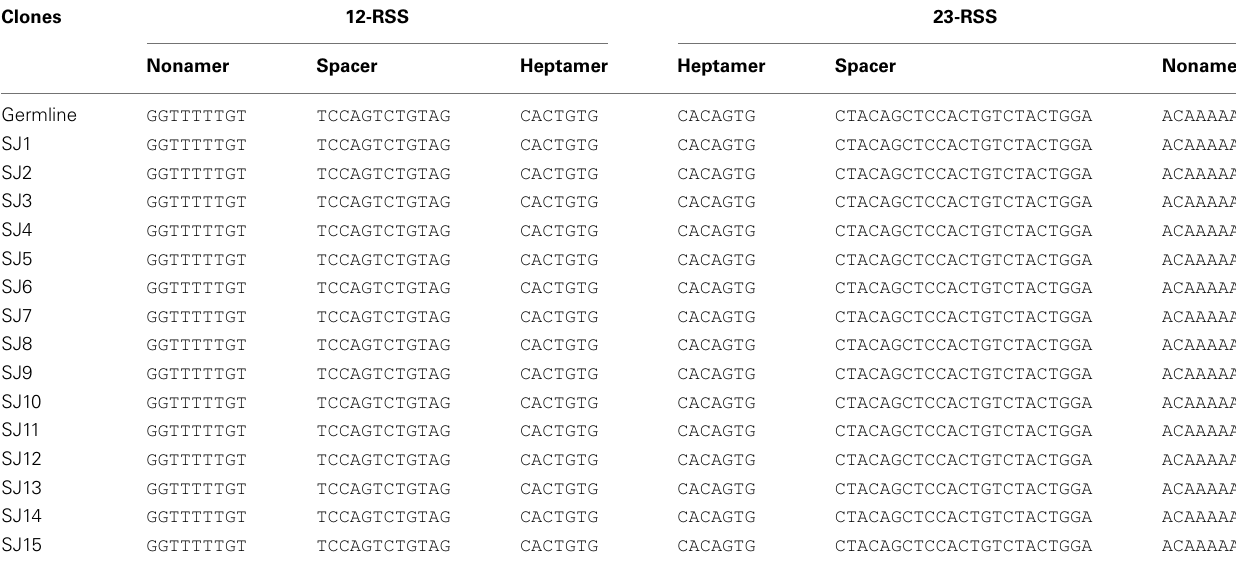
Table 4 | Sequences of rearranged GFPi-mRFP Con12/Con23